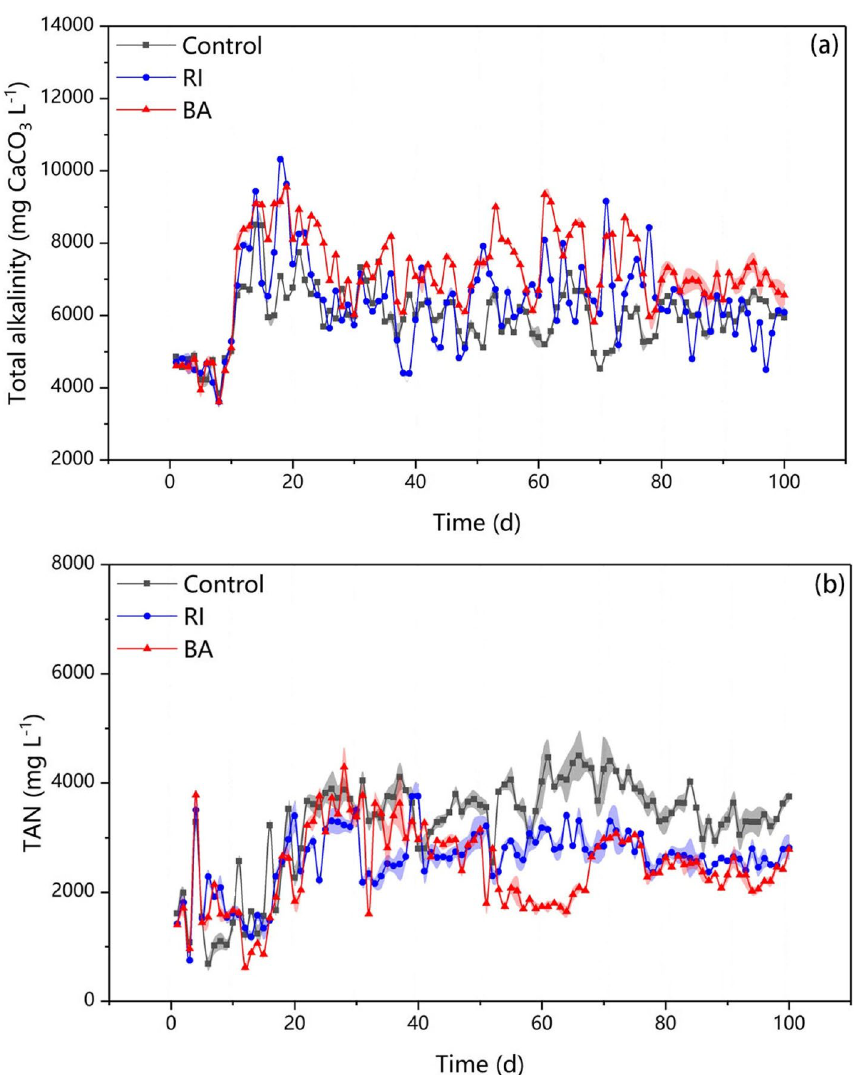
Fig. 5 Variations in the total alkalinity ( a ) and TAN concentrations ( b ) in different reactors. Shaded areas indicate error